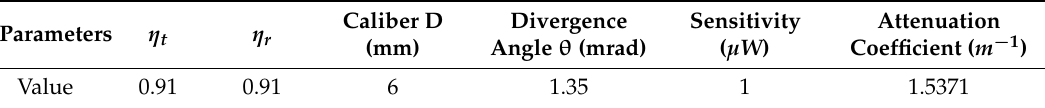
Table 2. Optical energy consumption